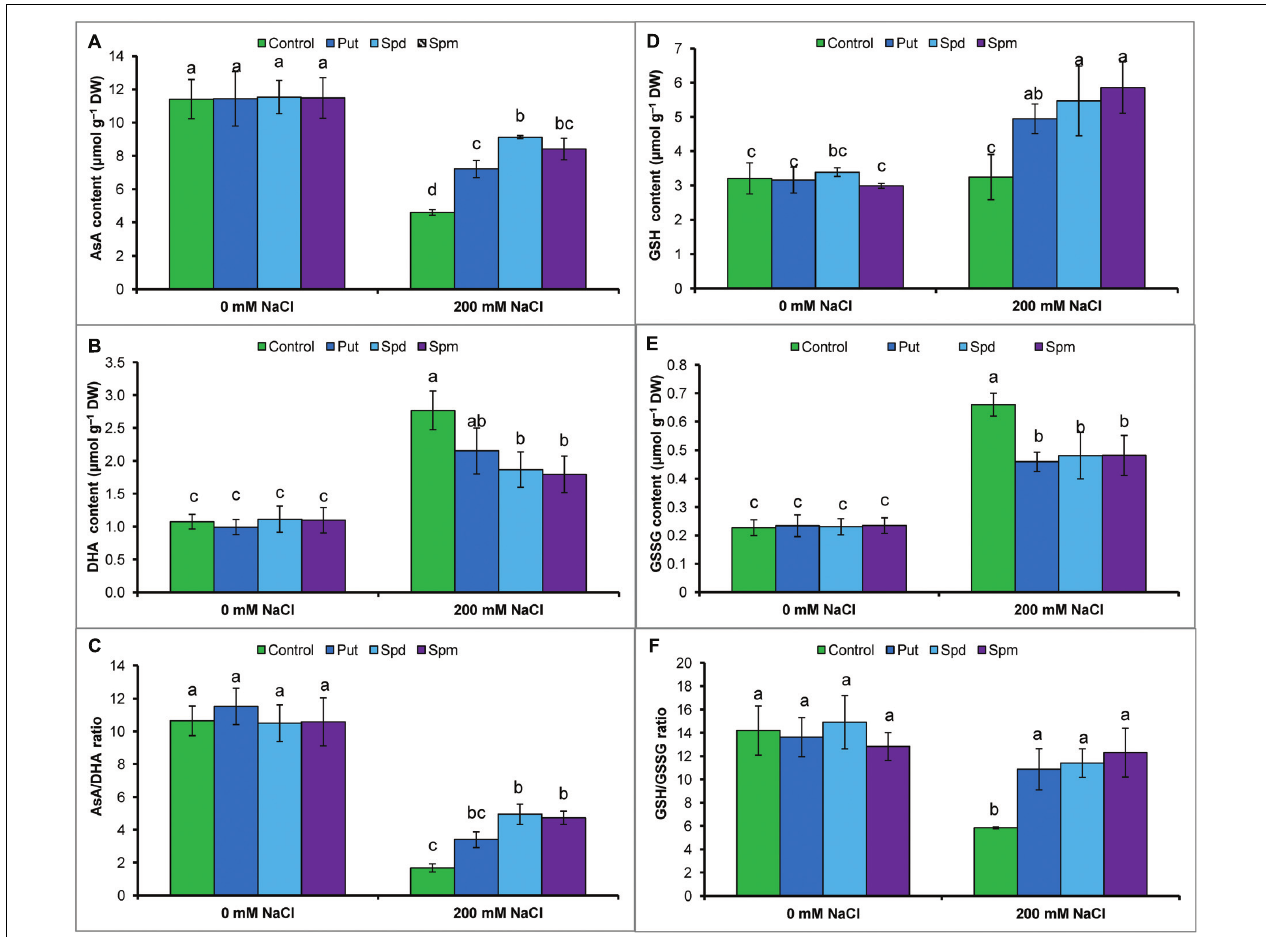
FIGURE 3 | Effect of exogenous polyamines on non-enzymatic antioxidants in mung bean seedlings under salt (NaCl, 200 mM) stress. Ascorbate (AsA) content (A) , DHA content (B) , AsA/DHA ratio (C) , GSH content (D) , GSSG content (E), and GSH/GSSG ratio (F) . Here, Put, Spd, and Spm indicate putrescine (0.2 mM), spermidine (0.2 mM), and spermine (0.2 mM), respectively. Mean ( ± SD) was calculated from three replicates for each treatment. Bars with different letters are significantly different at P ≤ 0.05 applying Tukey’s HSD